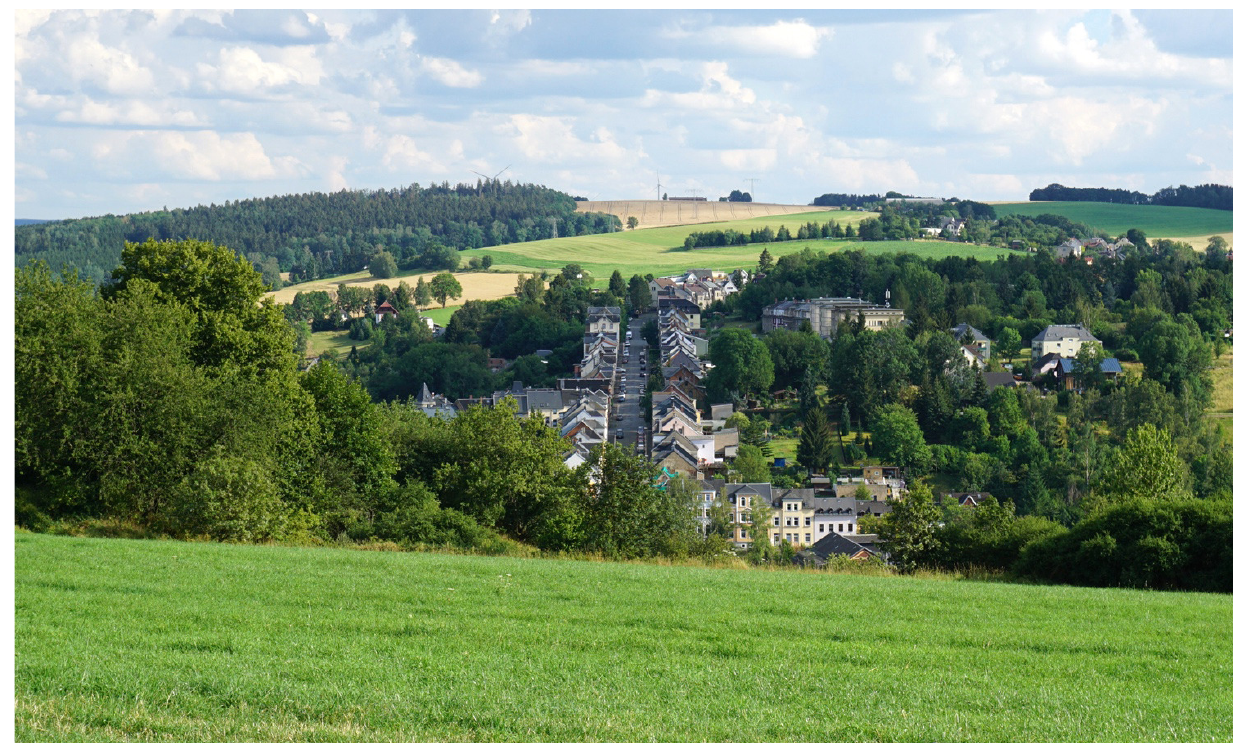
Figure 1. Condensed settlement structures and natural surroundings in Mylau, Saxony